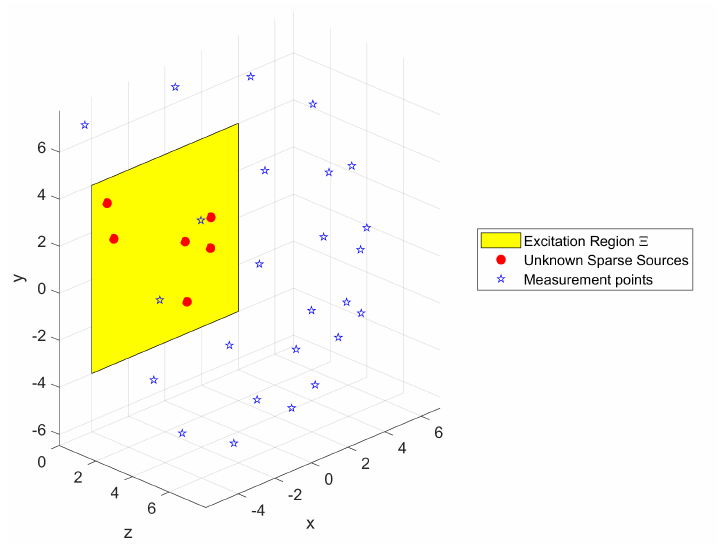
Figure 2. Scheme of the measurement system. The field radiated by the AUT sources is measured in M points having coordinates ( x ) in radiative near-field area of the antenna [2]; the measurements are supposed m , y m , z m to be affected by additive white Gaussian